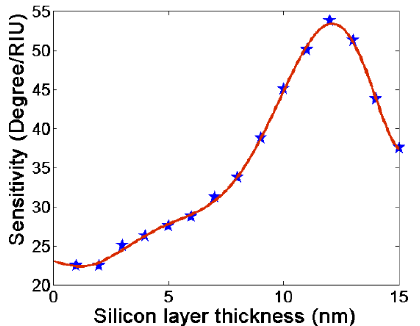
Figure 4. Sensitivity variation with silicon layer thickness for a gas sensing probe with 50 nm of Au and 13 layers of graphene. Maximum sensitivity is calculated to be 53.75 degree/RIU. The star symbols are simulated data points, which are fitted with red line.